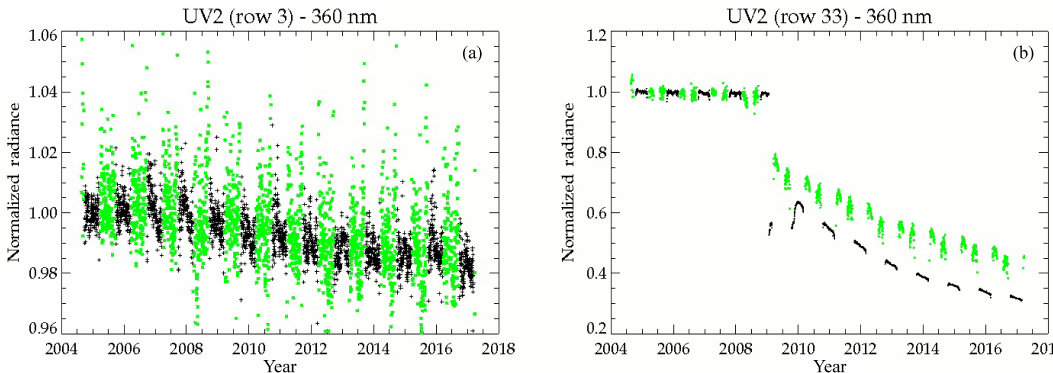
Figure 31. Measured daily mean radiances in UV2 at 360nm over Antarctica (black) and Greenland (green) are shown as a function of time relative to initial measurements in 2004. Left panel shows results in row 3, which is at the western edge of the OMI swath and is far from the row-anomaly-related blockage. Right panel shows results for row 33, which is near nadir and is affected by RA.